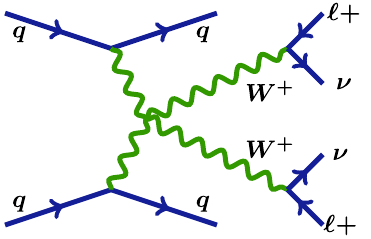
Fig. 1 A representative tree-level Feynman diagram of the VBS pro- cessattheLHC,involvingaquarticweakbosoncoupling.Thescattered quarkshadronizetojetsandtheWbosonsdecayleptonicallyinthegiven example, resulting in two (undetectable) neutrinos in the final